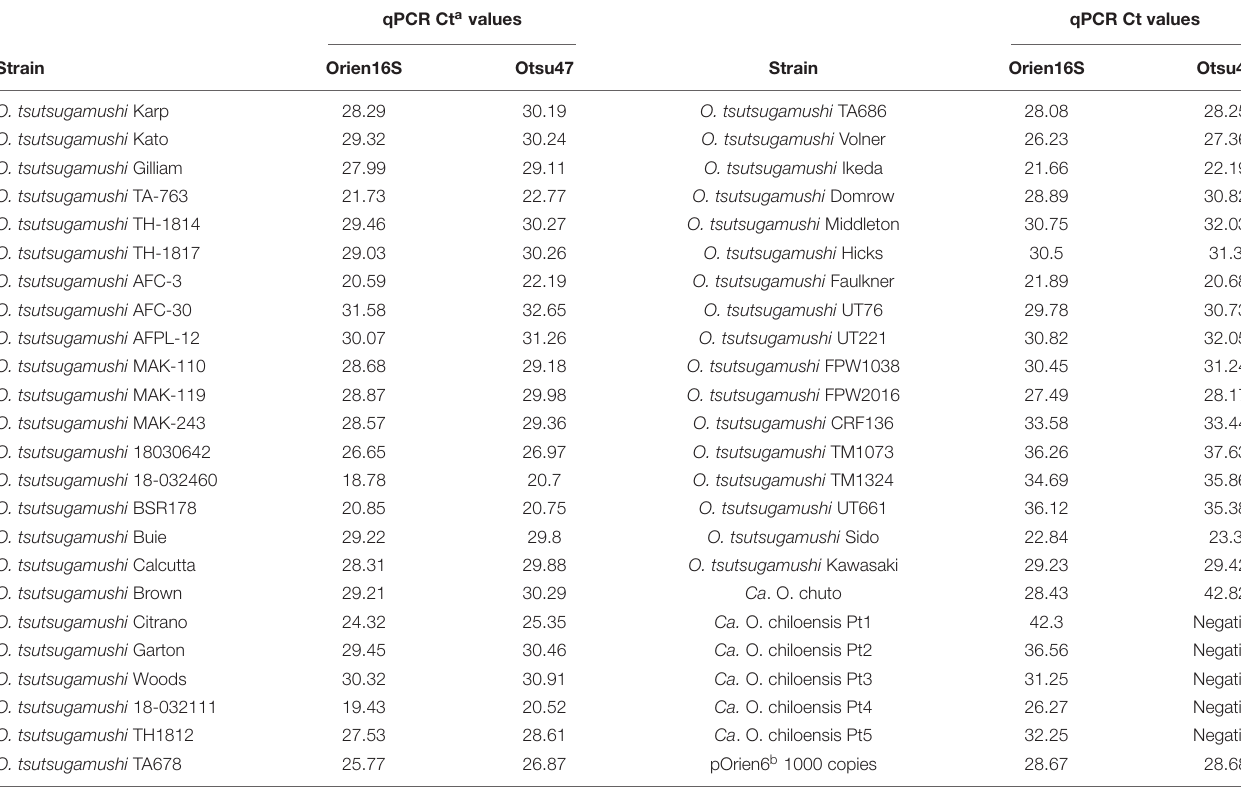
TABLE 2 | Comparison of the amplification characteristics (Ct values) of Orien16S and Otsu47 qPCR assays with samples of Orientia tsutsugamushi , Ca. Orientia chuto, and Ca. Orientia